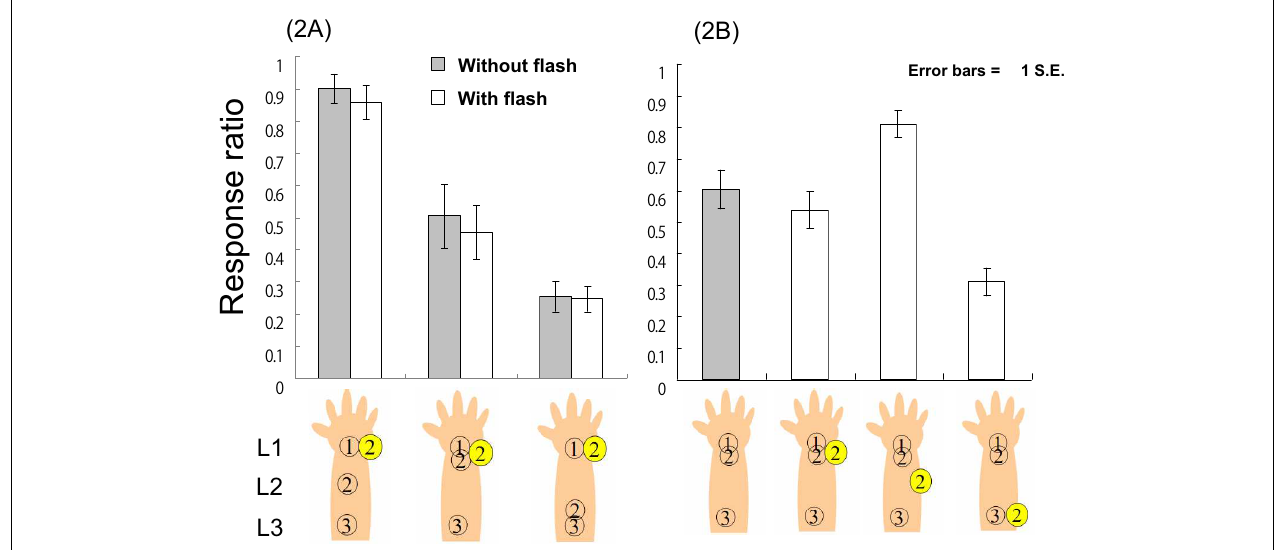
FIGURE 3 |The response ratio (L1–L2–L3 tactile feeling) in Experiment 2A and B.